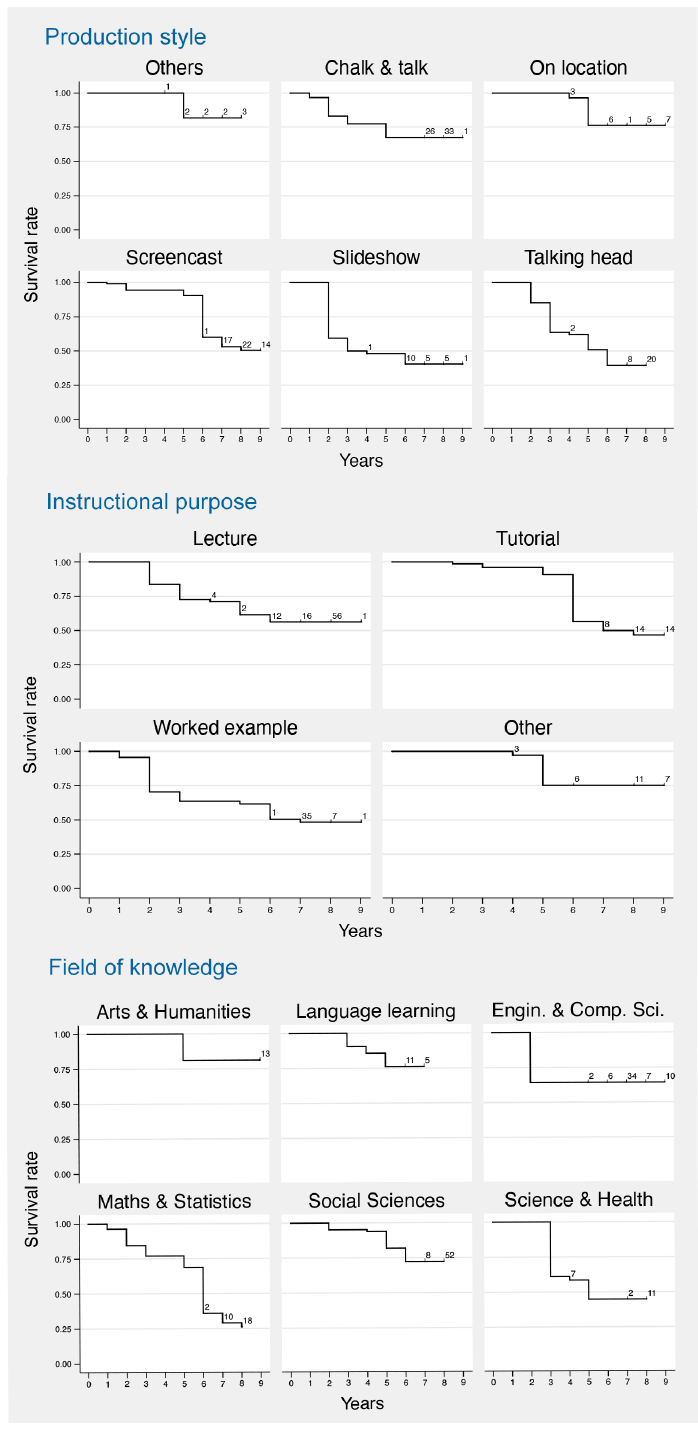
Kaplan–Meier Curves for Survival Estimates of Life Span (Three